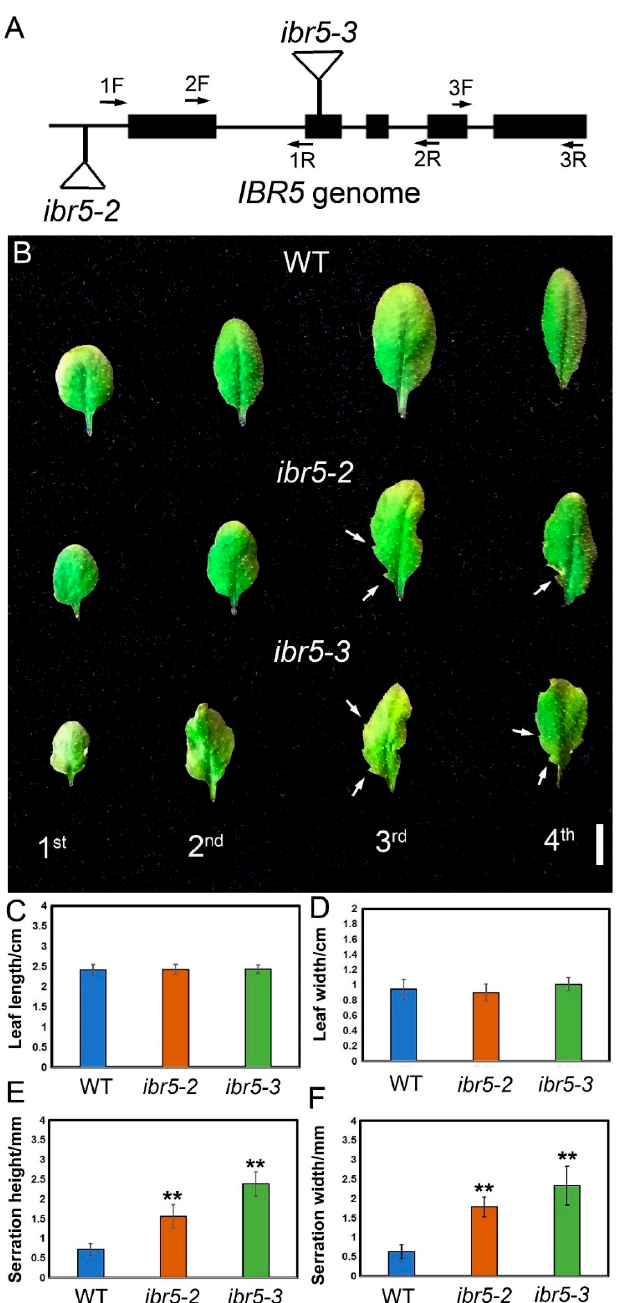
Figure 1. ibr5-3 mutants showing defective leaf shape. ( A ) The schematic illustration of the T-DNA insertion mutants for IBR5 used in this study [23,26,27]. ( B ) Phenotypic characterization of WT, ibr5-2 and ibr5-3 . The white arrows indicate the leaf serrations. Bar, 1 cm. ( C ) The length analysis of the third leaf in WT, ibr5-2 , and ibr5-3 . Error bars indicate ± SD; 12 leaves from 12 individual plants were analyzed. ( D ) The width analysis of the third leaf in WT, ibr5-2 , and ibr5-3 . Error bars are ± SD; 12 leaves from 12 individual plants were analyzed. ( E ) The maximum height analysis of the most proximal serrations of the third leaf in WT, ibr5-2 , and ibr5-3 . Error bars are ± SD; 11 leaves from 11 individual plants were analyzed. Two asterisks mean significant di ff erences ( p < 0.01 from Student’s t -test). ( F ) The maximum width analysis of the most proximal serrations of the third leaf in WT, ibr5-2 , and ibr5-3 . Error bars are ± SD; 11 leaves from 11 individual plants were analyzed. Two asterisks mean significant di ff erences ( p < 0.01 from Student’s t